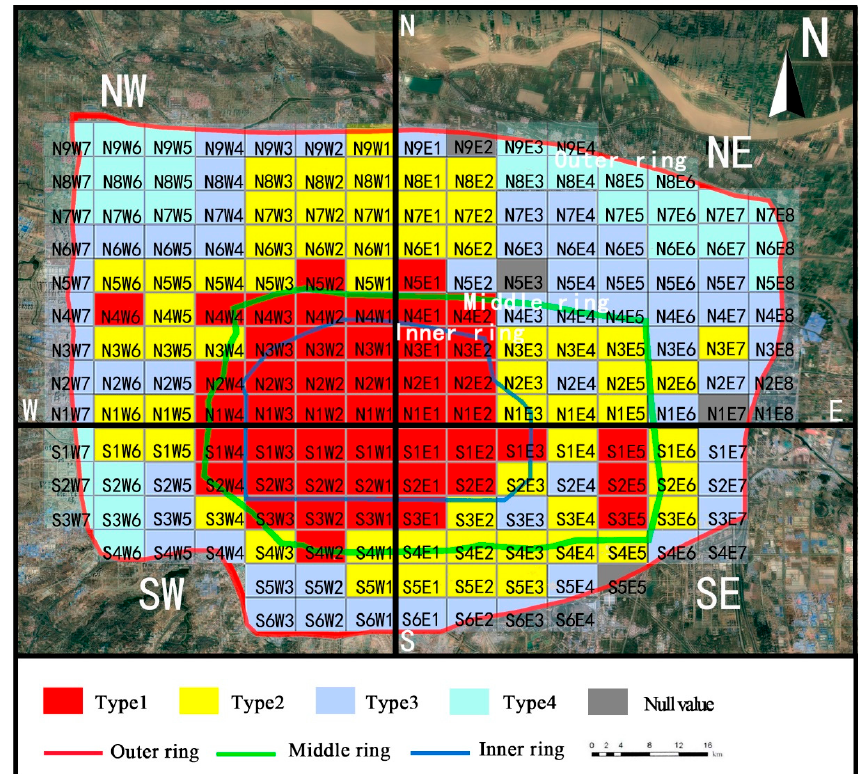
ISPRS Int. J. Geo-Inf. 2022 , 11 , 622 Figure 5. 2D space buildings form in the Fourth Ring Road of Zhengzhou. Figure 5. 2D space buildings form in the Fourth Ring Road of Zhengzhou.